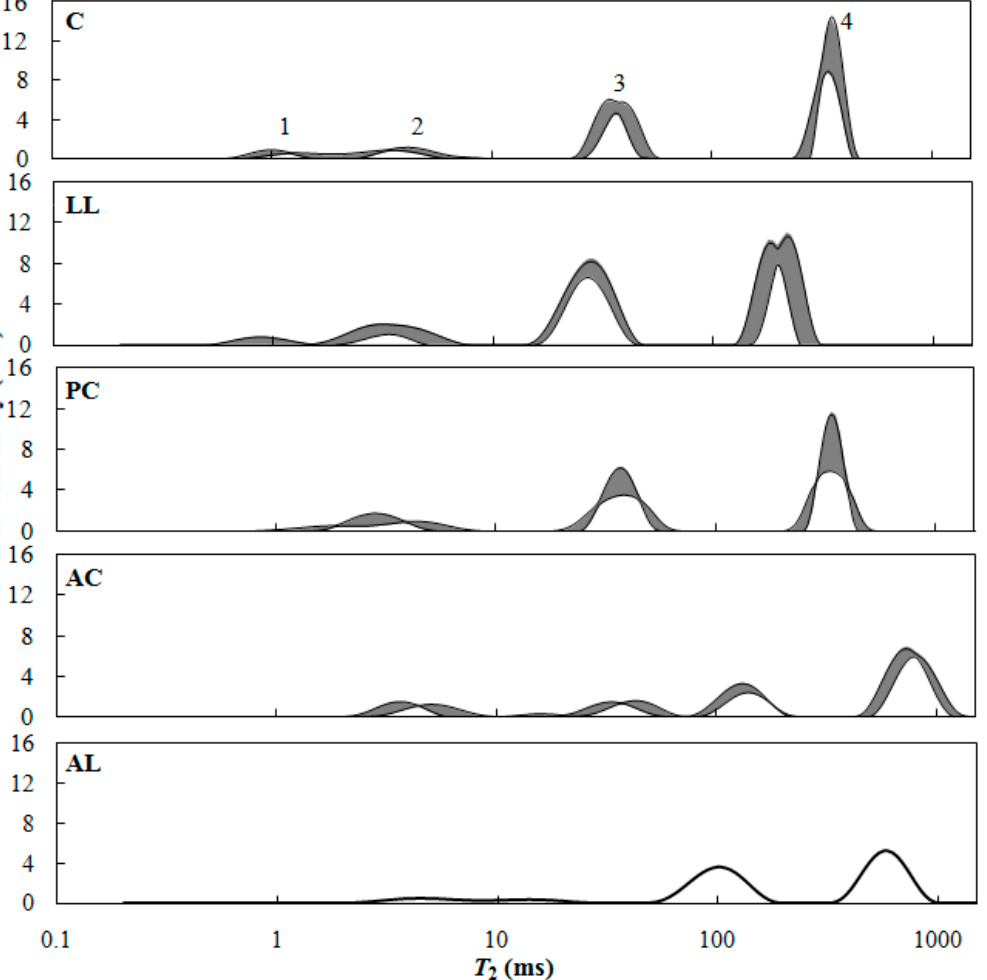
Figure 5. Continuous T 2 (spin–spin) distributions for control wood (C), wood with low lignin (LL), pyridine-treated wood (PC), acetylated wood (AC), and acetylated wood with low lignin (AL). Gray filled areas represent mean values including standard deviation.